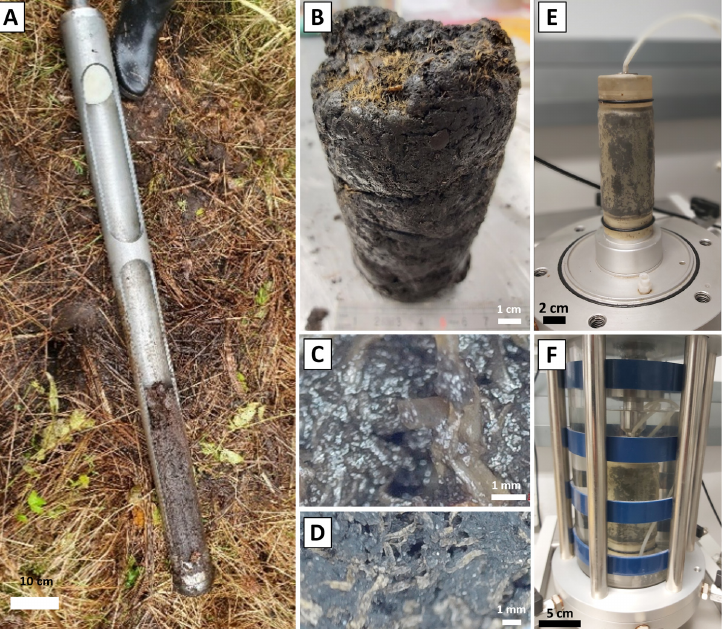
Figure 3. Peat study material (Samples #2 and #3): ( A ) sampler core, ( B ) soil after it was pulled out of the sampler, ( C ) peat with natural water content, ( D ) dried peat (after water content test), ( E ) trimmed sample in the rubber membrane, and ( F ) sample inside a triaxial cell. Photos: Ł . Kaczmarek, M. Grodzka- Ł ukaszewska.